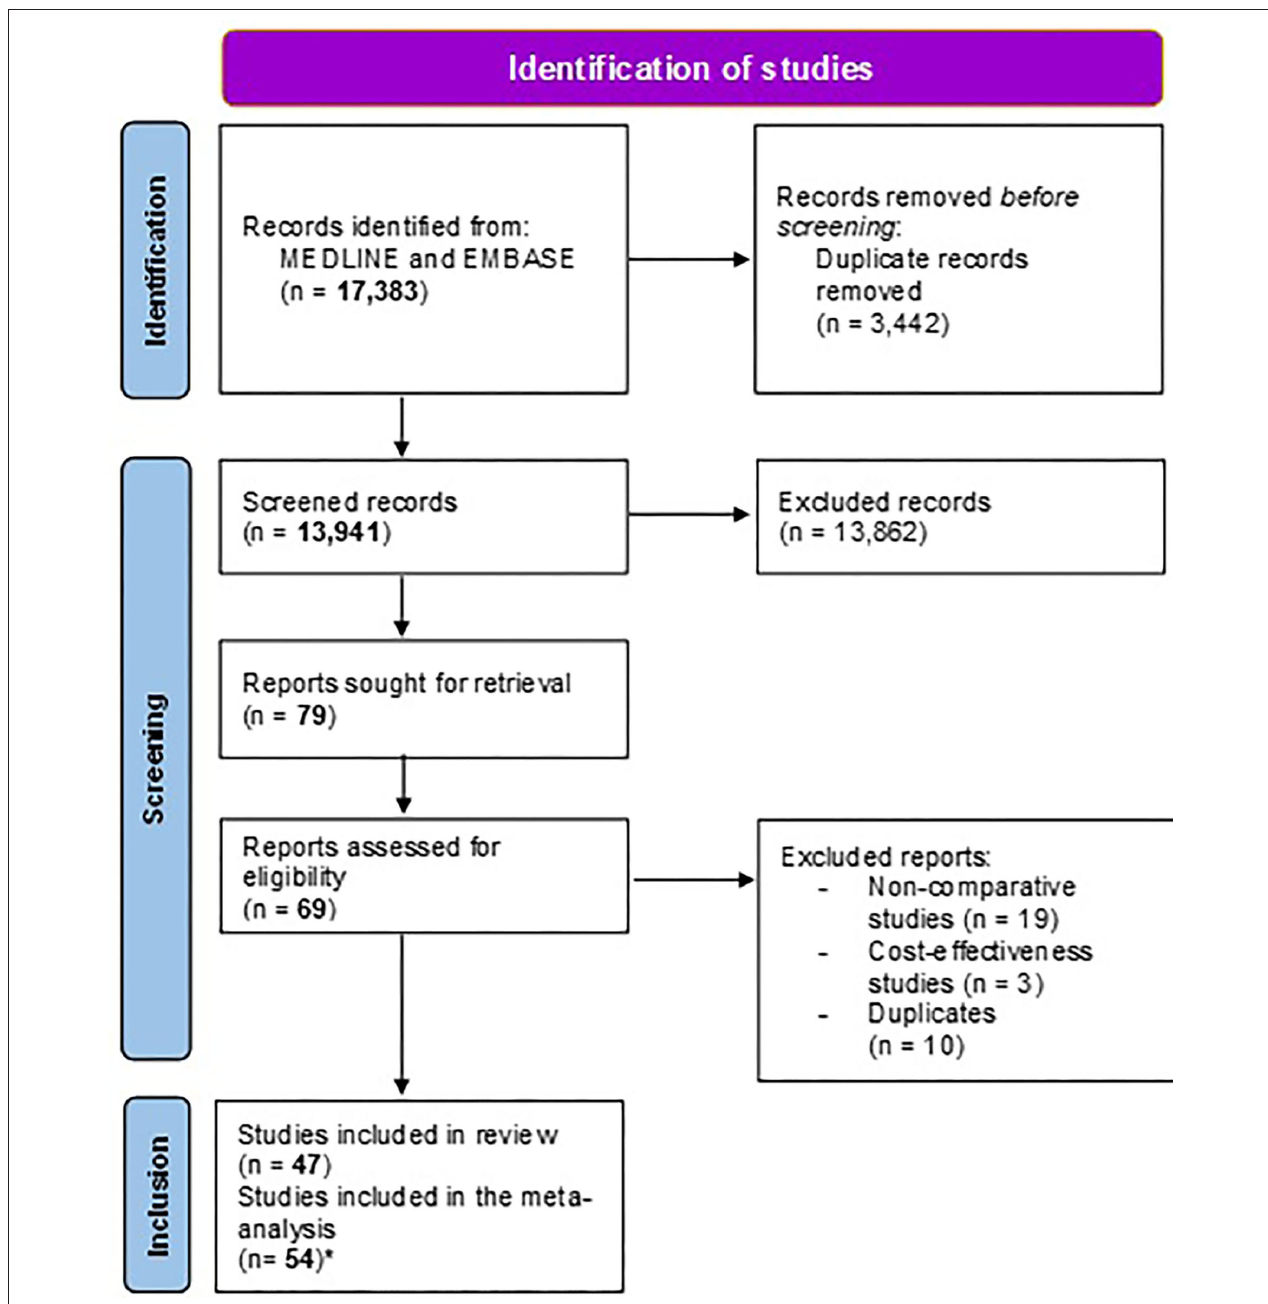
FIGURE 1 | Study flow chart. * The number of studies included in the meta-analysis is higher than the number of studies included in the systematic review because certain studies included different treatment groups that were meta-analyzed separately (i.e., we considered as many study groups/comparisons as treatment arms).